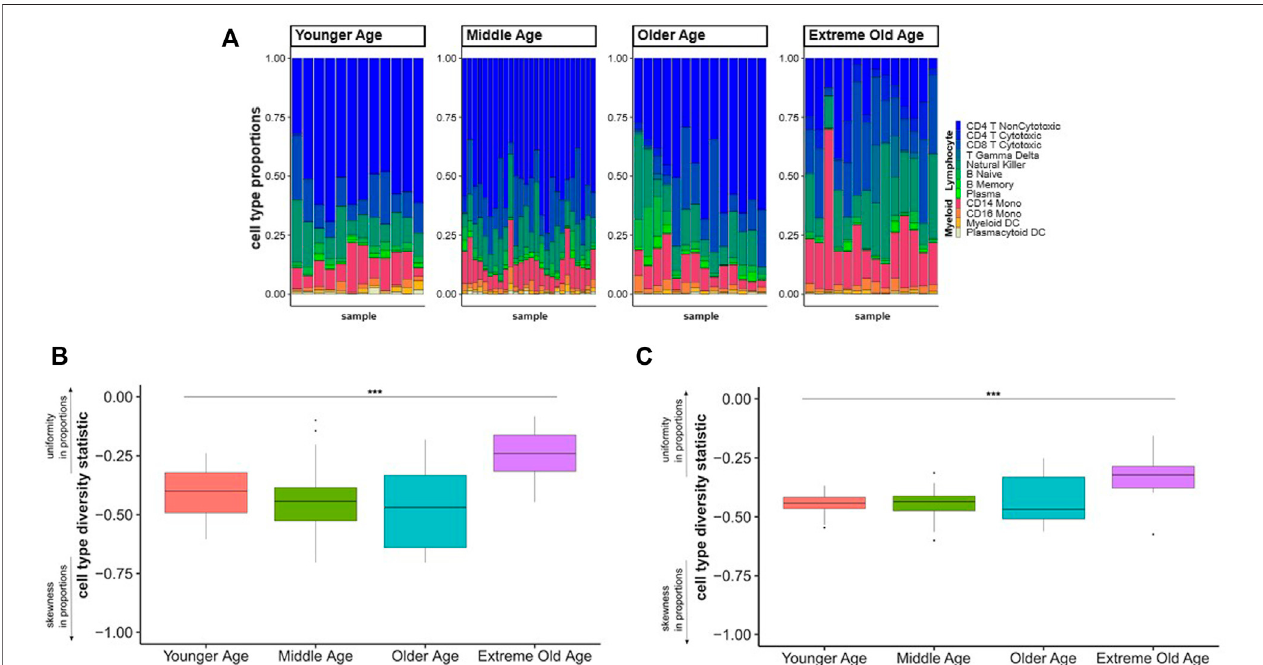
FIGURE1| CelltypediversitystatistictosummarizePBMCscompositionacrossagegroups. (A) .Proportionsof12celltypesdiscoveredinscRNA-seqofPBMCs from different age groups. Each bar represents the proportions of lymphocyte (blue-green gradient) and myeloid (red-yellow gradient) cell types ( y -axis) in a sample. (B) . Each boxplot represents the distribution of the diversity statistic of the proportions of lymphocyte and myeloid cells in younger, middle, older, and extreme old age individuals ( x -axis). The differences of the statistics across age groups were statistically signi fi cant (F-test p -value = 0.0001873) (C) . Each boxplot represents the distributionofthediversitystatisticoftheproportionsofthe12celltypesgroupedbyyounger,middle,older,andextremeoldage( x -axis).Thedifferencesofthestatistics across age groups were statistically signi fi cant (F-test p -value = 0.0001875). The diversity statistic was signi fi cantly higher, in the extreme old age group compared to each younger age control group: younger age group (t-test p -value = 0.00115), middle age group (t-test p -value = 0.00016), and older age group (t-test p -value =